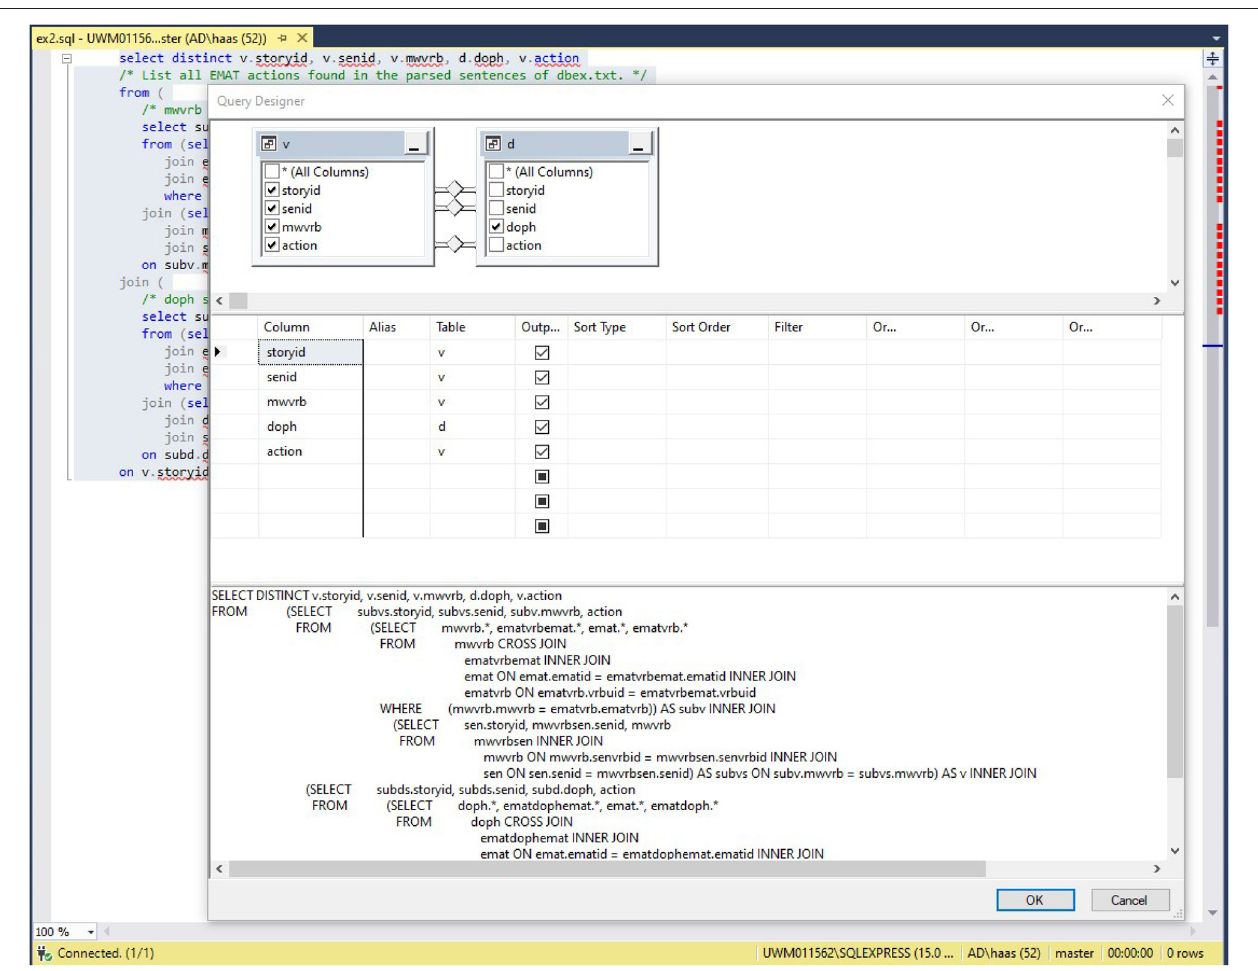
FIGURE 3 | Query diagram of the SQL query of Figure 2 . The diagram appears in the Diagram pane of the Query and View Designer tool. This pane allows query design through drag-and-drop mouse operations. The middle screen is the Criteria pane and allows query design through spreadsheet-type entries. The bottom screen is the SQL pane and contains the parsed version of the hand-written SQL code that appears in the background window. The red bars on the right-hand side of this window indicate the beginning and content of SQL select